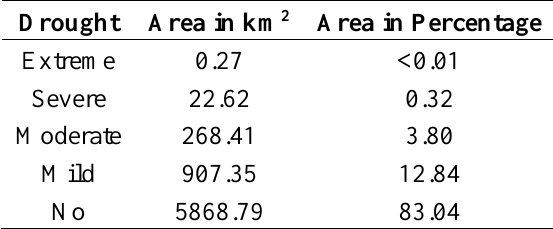
Table 5. Drought areas in km 2 and percentage according to the severity of